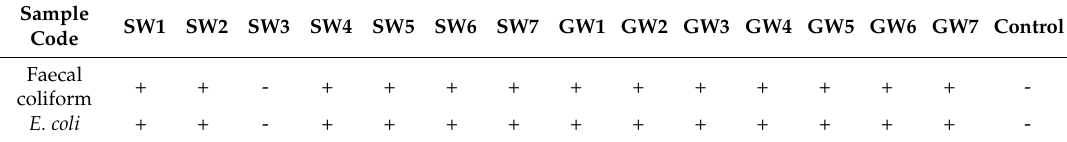
Figure 1. The total coliform determination of the water sources. Table 4. The faecal coliform and E. coli detection in the Samples.